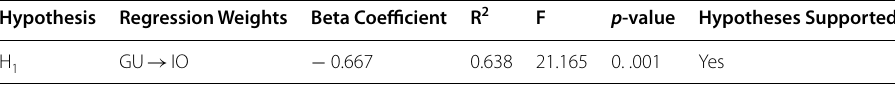
Table 14 Summary of Hypothesis 2 results